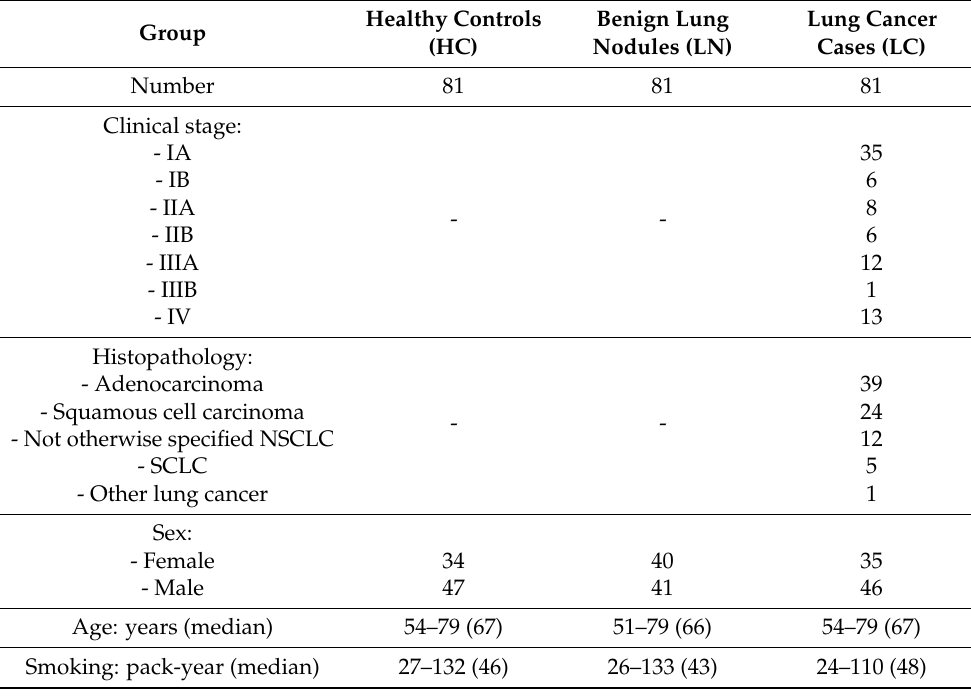
Table 1. Characteristics of donor